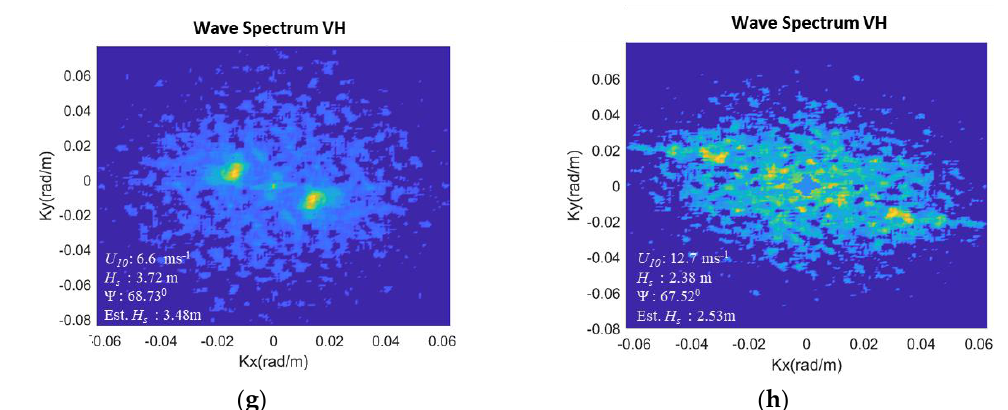
Figure 2. 5 km × 5 km subset taken from the 10 km × 10 km SAR Normalized Radar Cross Section (NRCS) of VV ( a ) and VH-polari- zations ( c ) on 27 March 2017, co-located with NDBC 51000 and SAR NRCS of VV ( b ) and VH-polarizations ( d ) on 26 April 2017, co- located with NDBC 46054. 2-D wave spectrum of the SAR VV ( e ) and VH ( g ) NRCS on 27 March 2017, and spectra of the SAR VV ( f ) and VH ( h ) NRCS on 26 April 2017.